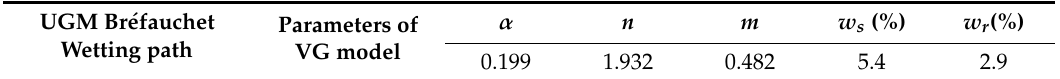
Table 1. Parameters of van Genuchten